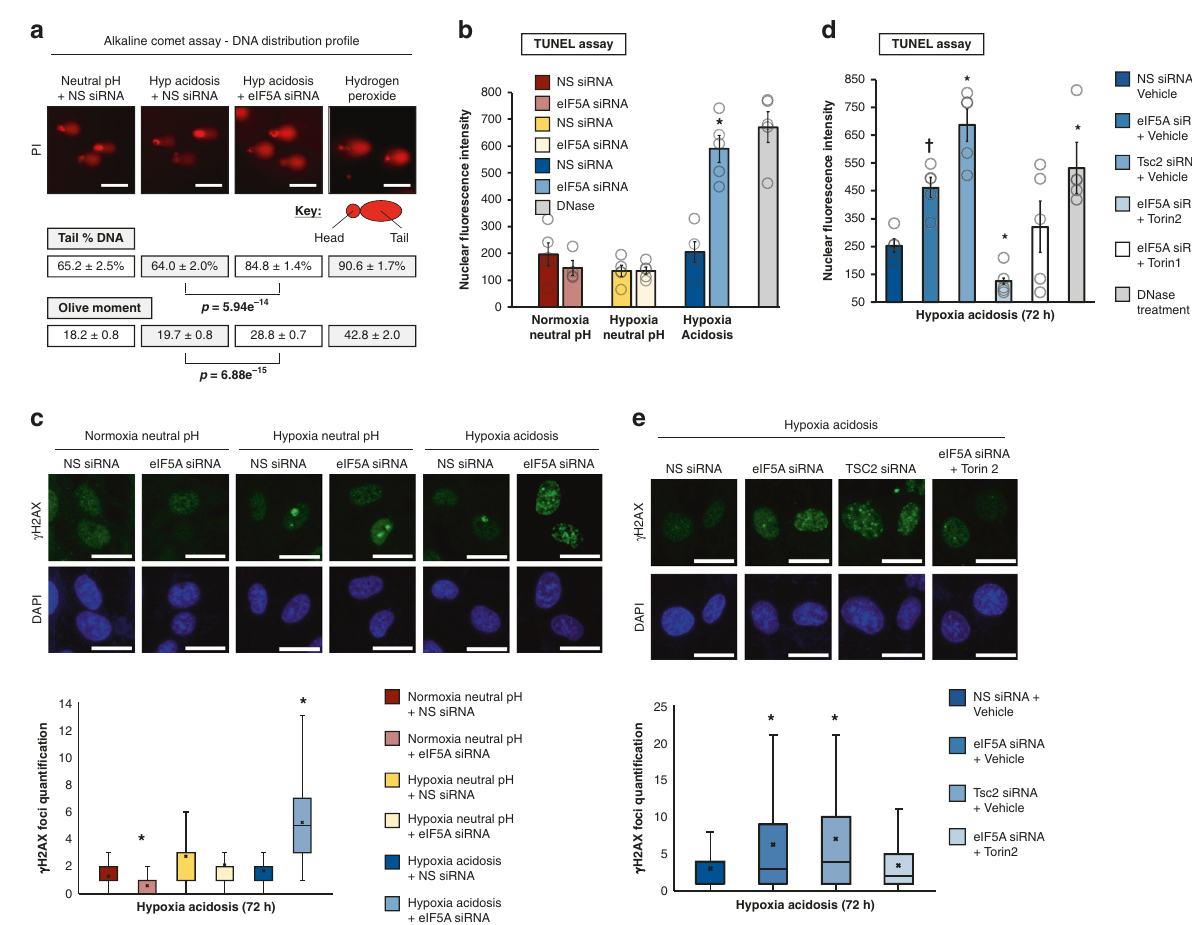
Fig. 5 The eIF5A/Tsc2 axis averts DNA damage. Assessment of the effect of eIF5A silencing on DNA damage by a alkaline comet analysis ( n = 3) and b TUNEL measurements in U87MG subjected to indicated conditions. Data represent mean ± SEM ( n = 5). Asterisk indicates p = 0.001 compared to NS siRNA, two-sided student ’ s t test. c (Top) Representative images of yH2AX foci in U87MG subjected to indicated conditions. Scale bars: 20 μ m. (Bottom) analysis of yH2AX foci ( n = 5), asterisk indicates p = 0.00001 and 0.00001 (NN eiF5A siRNA, HA eIF5A siRNA) compared to NS siRNA, two-sided Mann – Whitney U test. The top of the box denotes Q3, the bottom of the box represents Q1; middle line denotes median; X represents mean; bottom whisker denotes minimum: 1st quartile — (1.5*IQR); top whisker denotes maximum: 3rd quartile + (1.5*IQR). d TUNEL analyses of the effects of Tsc2 knockdown and mTORC1 inhibition (by Torin 1 and 2) on DNA damage in cells replete or depleted of eIF5A under hypoxia-acidosis conditions. Data represent mean ± SEM ( n = 5). An asterisk indicates p = 0.005, 0.004, 0.002, and 0.027 (eIF5A siRNA + vehicle, Tsc2 siRNA + vehicle, and eIF5A siRNA + torin2) compared to NS siRNA + Vehicle. † indicates p = 0.006 eIF5A siRNA compared to Vehicle and Tsc2 siRNA + Vehicle, two-sided student ’ s t test. e Top panel: representative images of yH2AX foci in U87MG cells depleted of Tsc2, and in eIF5A-replete or -depleted cells treated with mTORC1 inhibitors (Torin 1 and 2) under hypoxia-acidosis conditions. Bottom panel: analysis of yH2AX ( n = 5), an asterix indicates p = 0.0005 and 0.00001 (eIF5A siRNA, tsc2 siRNA) compared to NS siRNA + vehicle, two-sided Mann – Whitney U test. Top of the box denotes Q3, the bottom of the box represents Q1; middle line denotes median; X represents mean; bottom whisker denotes minimum: 1st quartile — (1.5*IQR); top whisker denotes maximum: 3rd quartile +